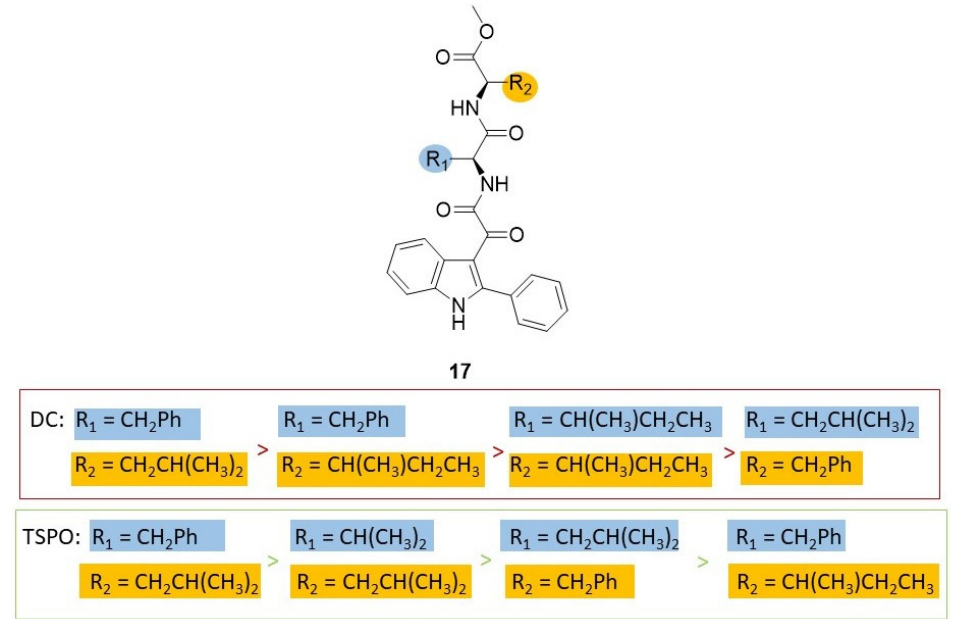
Figure 5. SAR [87] summary for dissociation of human p53/MDM2 complex (DC) and binding affinity to TSPO (TSPO) of indole based derivatives 17 .